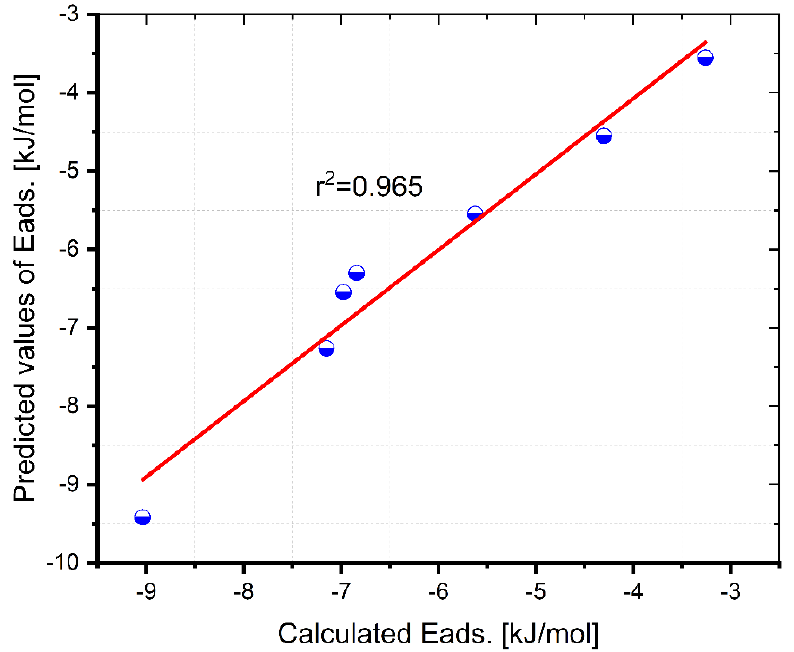
Figure 5. The DFT computed Eads. of PAH/G vs. the QSAR predicted values of Eads.